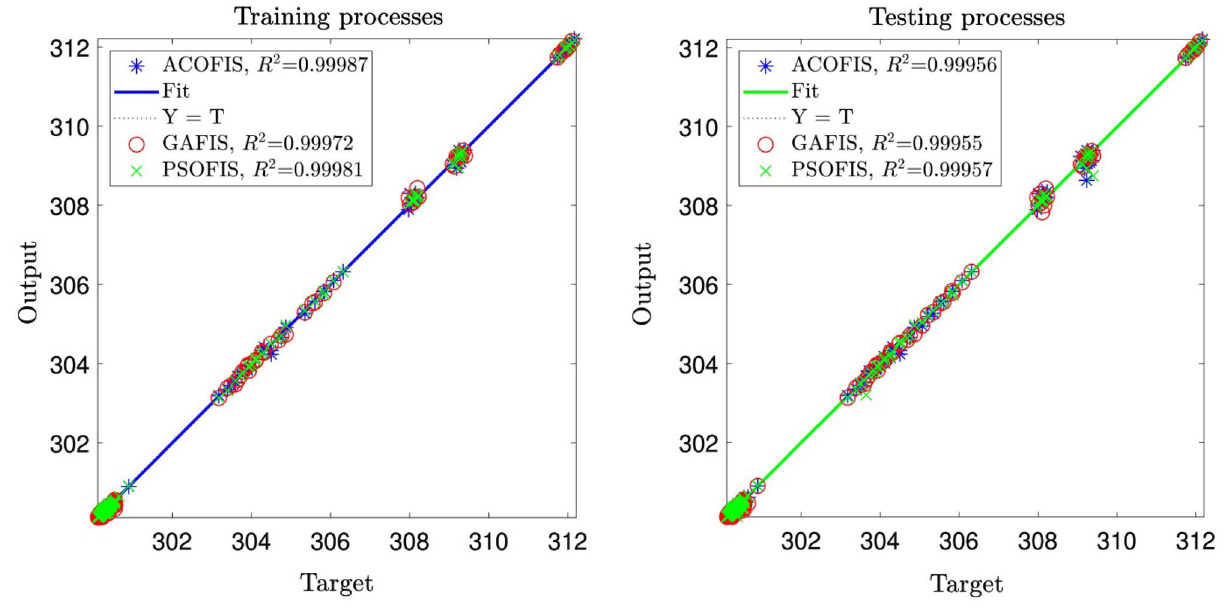
Figure 10. Comparison of coefficient of determination for training and testing processes for different methods.